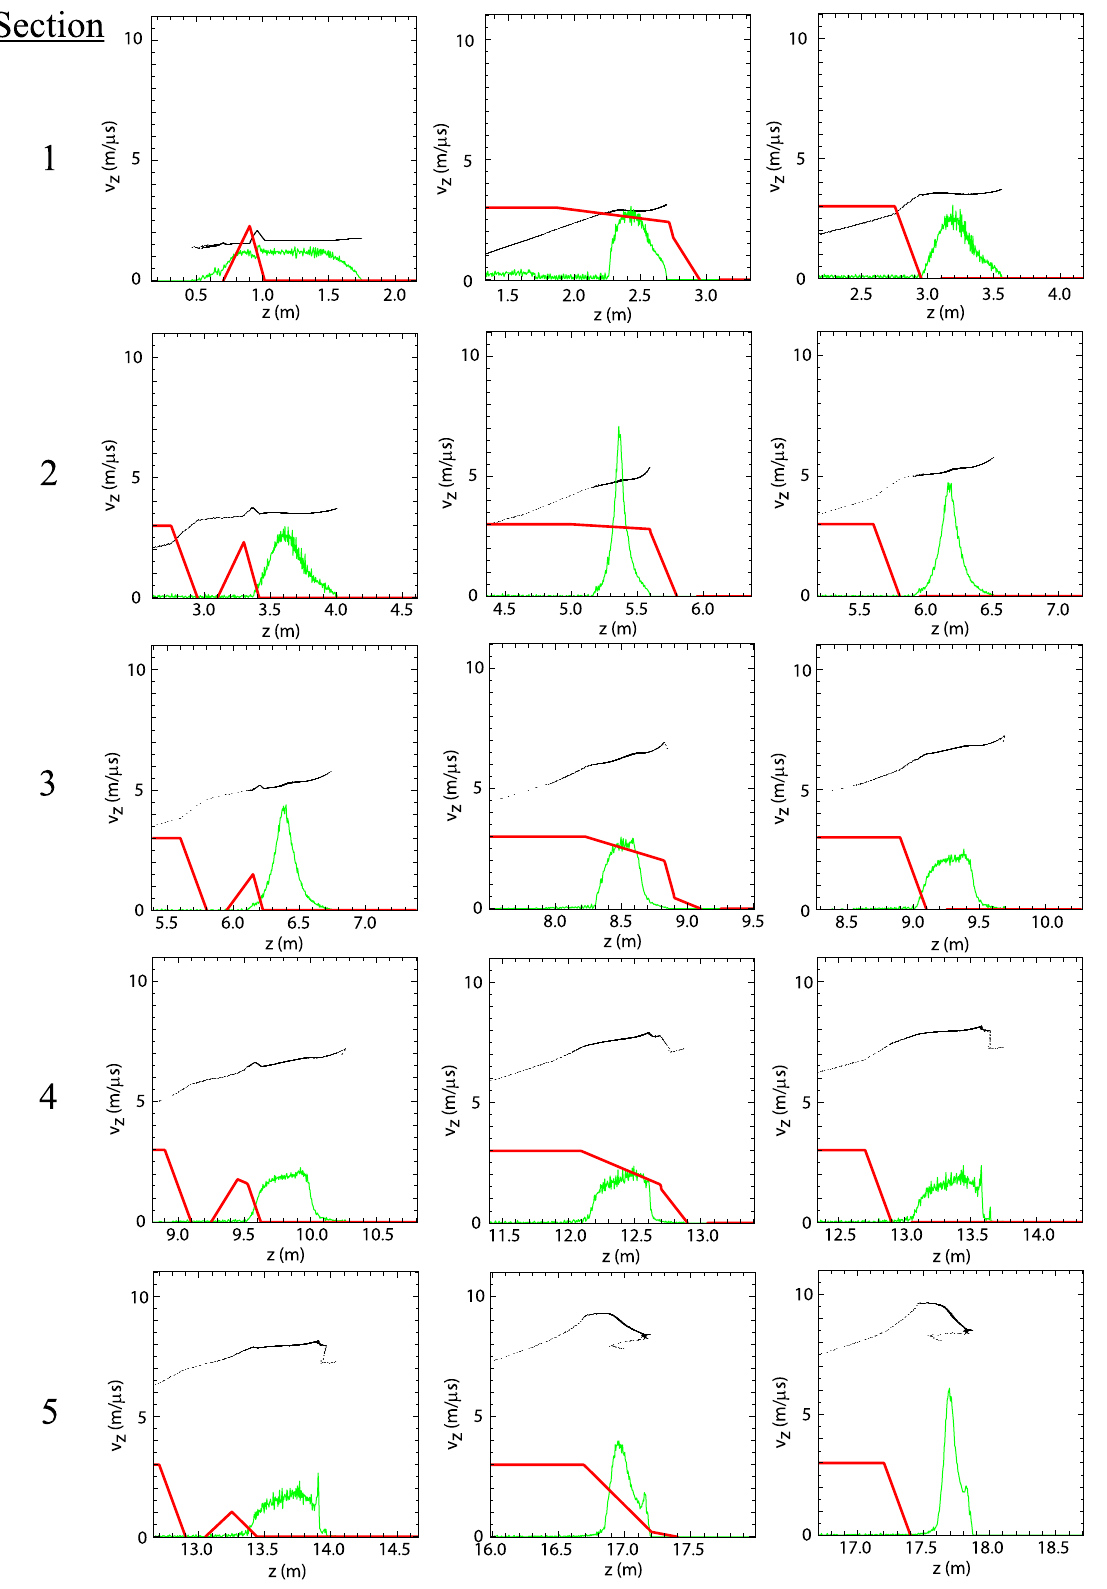
FIG. 10. (Color) The phase space of the ion beam when (i) it has entered the helix entirely, (ii) the voltage wave has swept through the entire ion beam, and (iii) the entire ion beam has exited the helix, for every section of the helix.